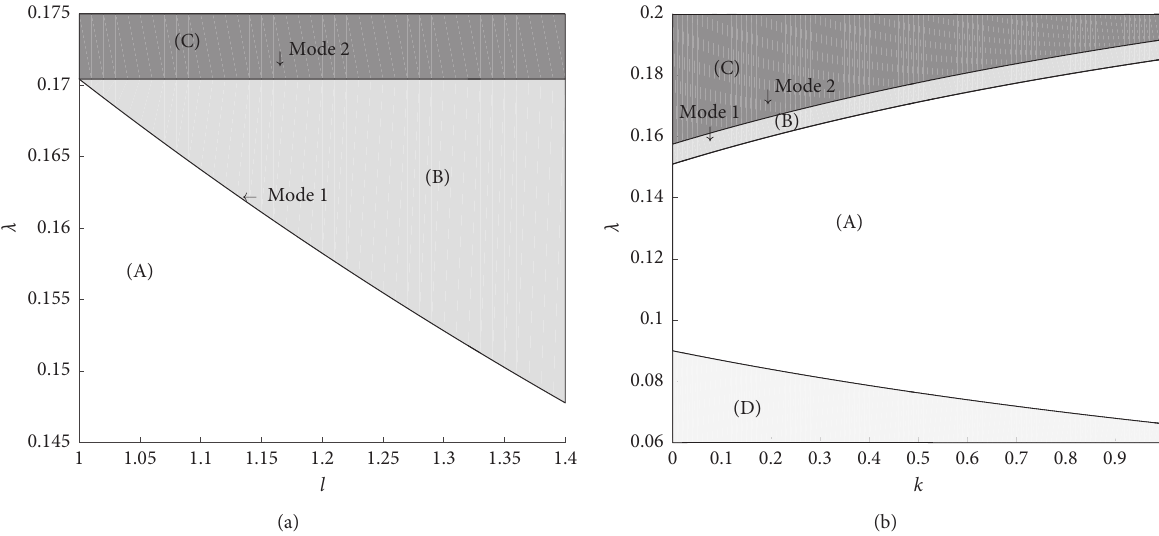
Figure 3: (a) The government decision on the subsidy as l changes. (b) The government decision on the subsidy as k changes.